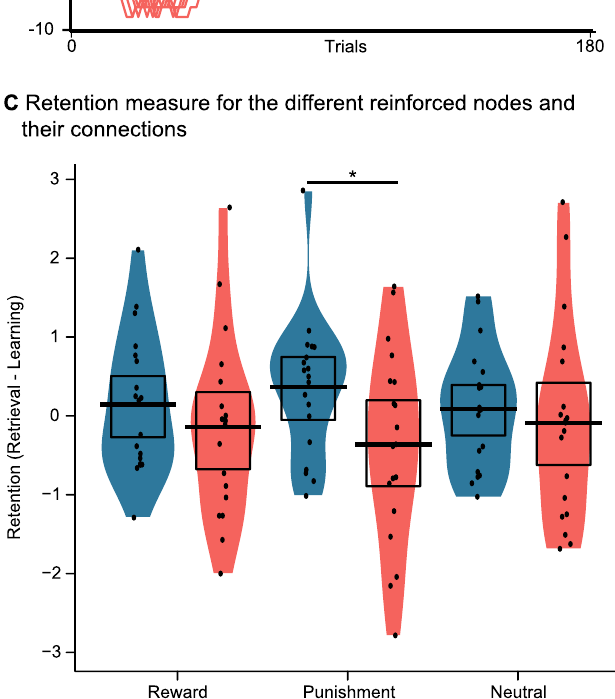
Figure 4. Reinforced nodes results. ( A ) Individual monetary balance curves during the reward task in the sleep and ( B ) the wake condition. Participants earned the amount reached at the end of the task. ( C ) Retention performance for the reinforced nodes. The black dots, bar and rectangle represent the individual performances, the mean and the 95% of a Bayesian highest density interval, respectively. The coloured shape shows the smoothed density. *p <